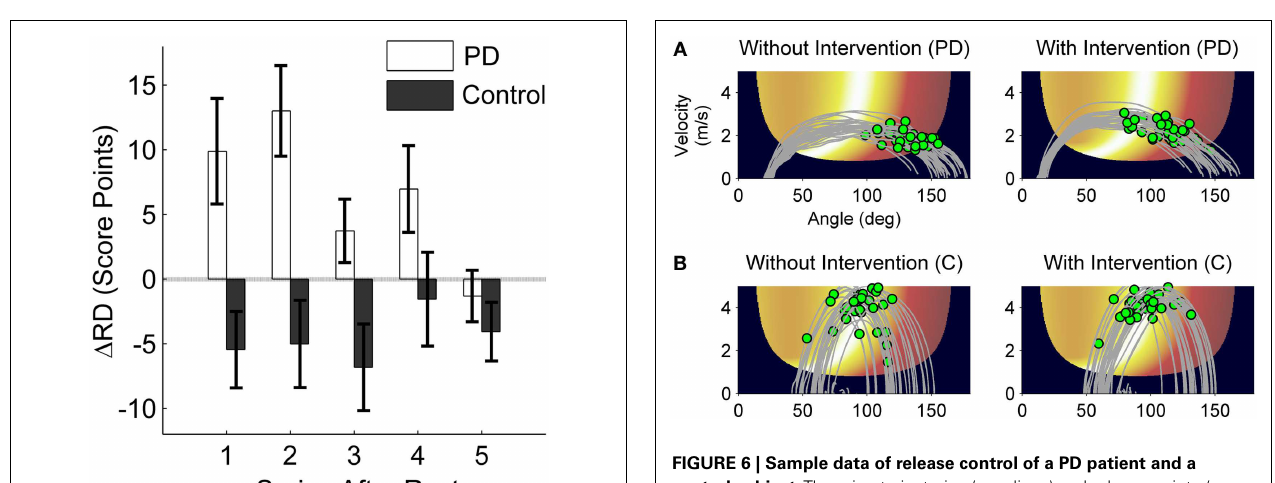
FIGURE 6 | Sample data of release control of a PD patient and a control subject. Throwing trajectories (gray lines) and release points (green dots) after rest without intervention (A) and with intervention (B) plotted on the execution and result space. Movement direction is from left to right.